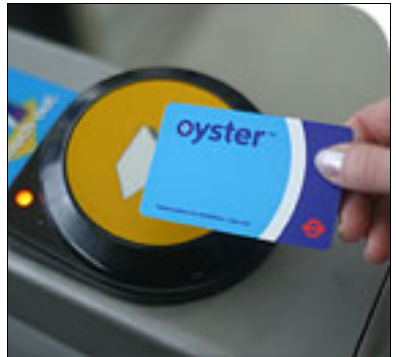
Fig 2. Validation of contactless smart